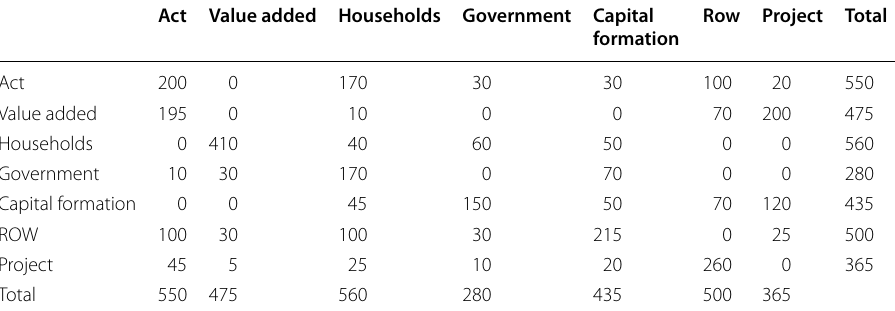
Table 3 SAM with project in the operational period ( t